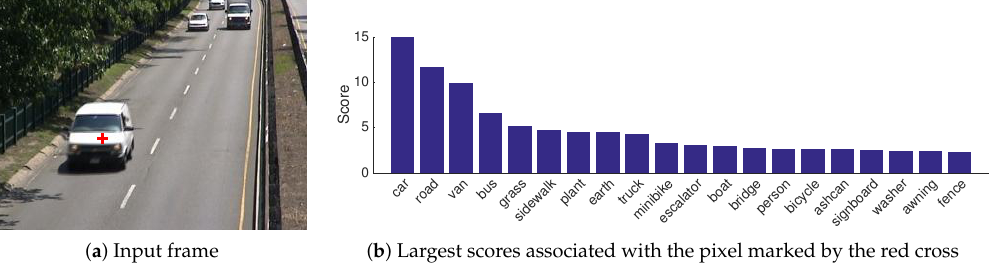
Figure 1. Example of a pixel marked by a red cross in the white car of the image ( a ) along with its 20 over 150 largest scores ( b ) returned by the PSPNet algorithm [9] (see Section